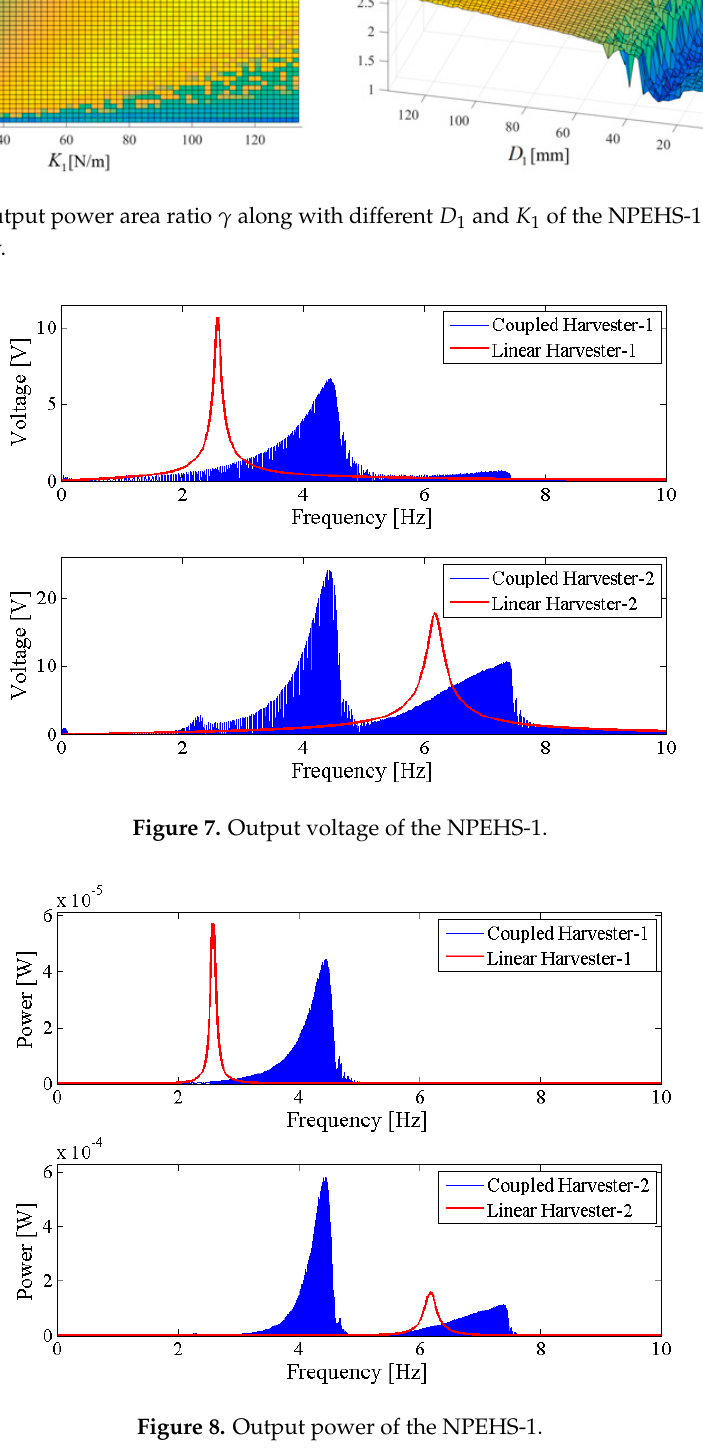
Figure 8. Output power of the NPEHS-1.